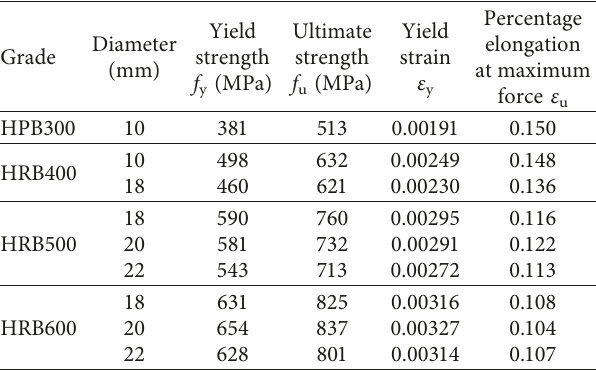
Figure 2: Stress-strain relationships of the tensile reinforcement. Table 2: Material properties of reinforcement.